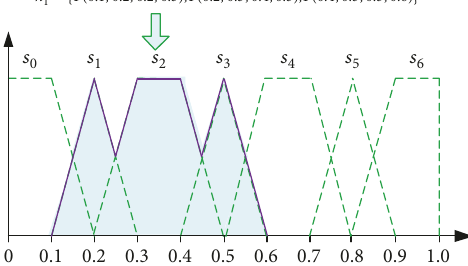
Figure 2: The HTrF semantic of the FLE fl 1 = { between 𝑙 1 and 𝑙 3 } . ̃ℎ (𝑥) is a set of different normalized TrFNs (a TrFN where 𝐻 𝑇 ̃ 𝛼 = 𝑇(𝑎, 𝑏, 𝑐, 𝑑) is the normalized TrFN if 𝑎 ≥ 0 and 𝑑 ≤ 1 ) used to represent the possible membership degrees of the ̃ℎ (𝑥) is called an HTrF element 𝑥 ∈ 𝑋 to 𝐻 𝑇 . Usually, 𝐻 𝑇 ̃ℎ} ̃ℎ = {̃𝛼 𝑓 | 𝑓 = 1, 2, . . . , # for value/number and denoted by ̃ℎ is simplification [17]. Each element ̃𝛼 𝑓 = 𝑇(𝑎 𝑓 , 𝑏 𝑓 , 𝑐 𝑓 , 𝑑 𝑓 ) in ̃ℎ ̃ℎ the normalized TrFN and # is the number of all TrFNs in